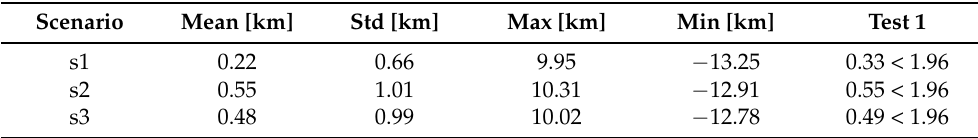
Table 2. Statistics on the differences of the Moho estimated by the two algorithms, (cid:98) D R − (cid:98) D O , for the three tested scenarios.